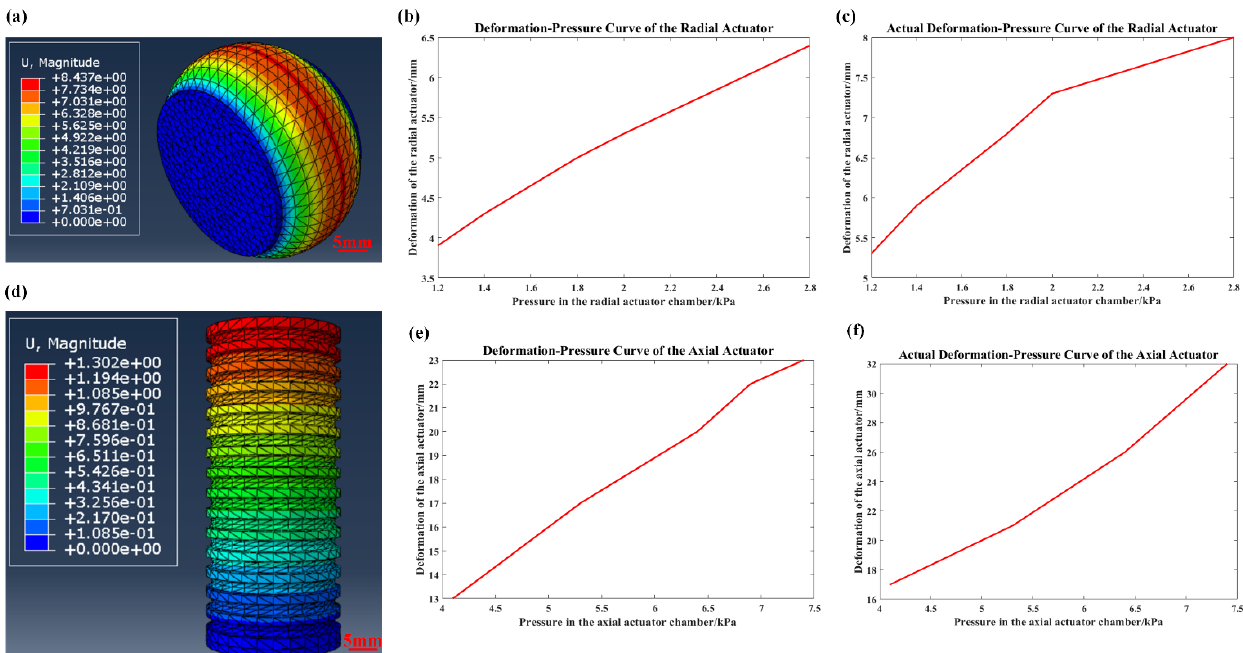
Figure 5. Numerical simulation and actual experiment of the radial actuator and axial actuator, respectively. ( a ) Simulation result of the deformation of the radial actuator. ( b ) Deformation–pressure curve of the radial actuator by numerical simulation. ( c ) Deformation–pressure curve of the radial actuator by actual experiment. ( d ) Simulation result of the deformation of the axial actuator. ( e ) Deformation–pressure curve of the axial actuator by numerical simulation. ( f ) Deformation–pressure curve of the axial actuator by actual experiment.